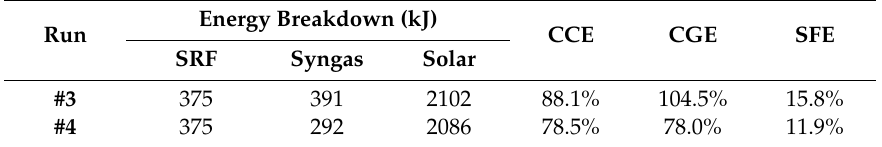
Table 6. Performance metrics for SRF Table 5. Gas yield and mass balance closure for SRF gasification.